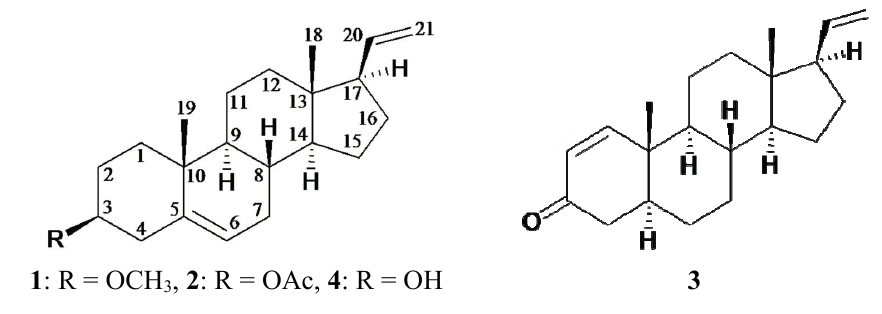
) and 13 C (175 MHz, CDCl 3